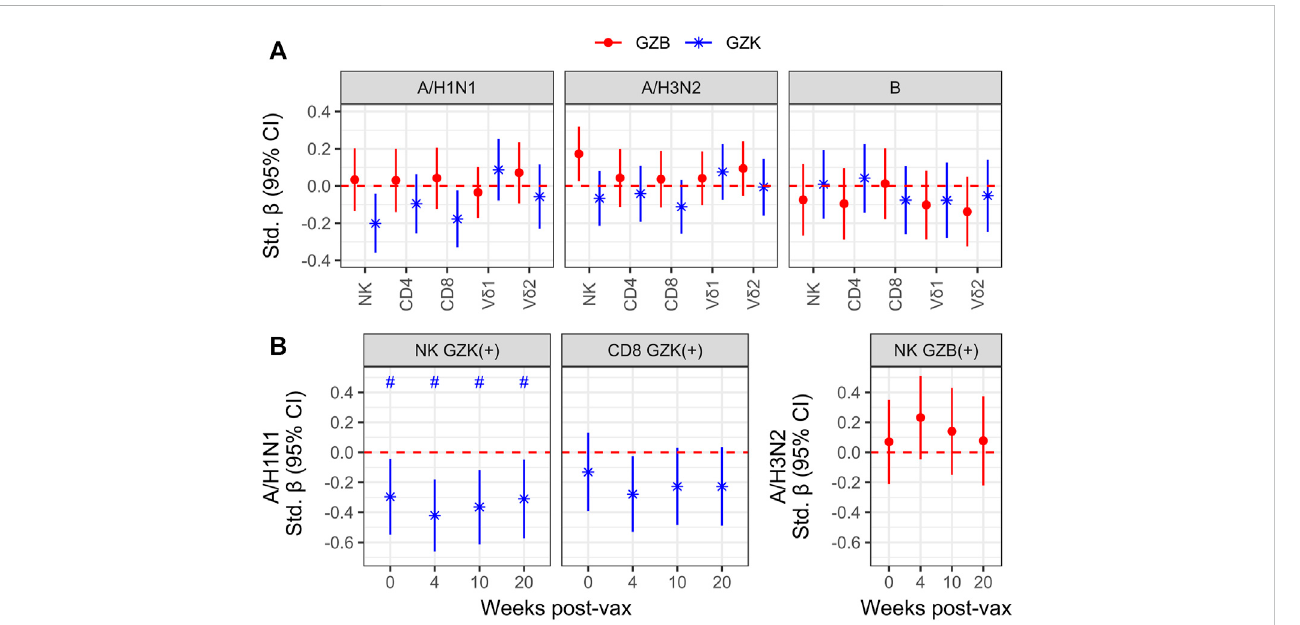
FIGURE 4 Granzyme-positive cell frequency is associated with vaccine responsiveness and antibody titres in older adults receiving the high-dose vaccine. (A) To model vaccine responsiveness, log-transformed titres for in fl uenza A/H1N1, A/H3N2 and B at 4-week post-vaccination were regressed on the log- transformed frequencies of GZB- or GZK-expressing cells, adjusting for age, sex, enrollment site and the log pre-vaccination titres. (B) Associations between A/H1N1 titre levels at baseline (i.e., 0), and 4-, 10-, 20-week post-vaccination with the frequency of GZK+ NK-cells or CD8 + T cells, omitting adjustment for pre-vaccination titres. No overlap of the 95% CI with the red dotted line indicates signi fi cance at the nominal level, while the ‘ # ’ indicates that signi fi cance was maintainted at an FDR adjusted p < .05. No signi fi cant differences beyond the nominal level were observed in (A) .